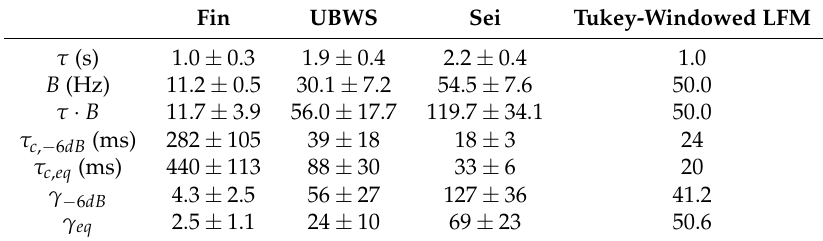
Table 1. The potential pulse compression gains, γ − 6 dB and γ eq , of the baleen whale species vocalization signals with corresponding uncompressed pulse width τ , spectral bandwidth B and time-bandwidth product τ · B . These parameters are also tabulated for a Tukey-window LFM pulse for comparison. The unidentified baleen whale species is indicated as